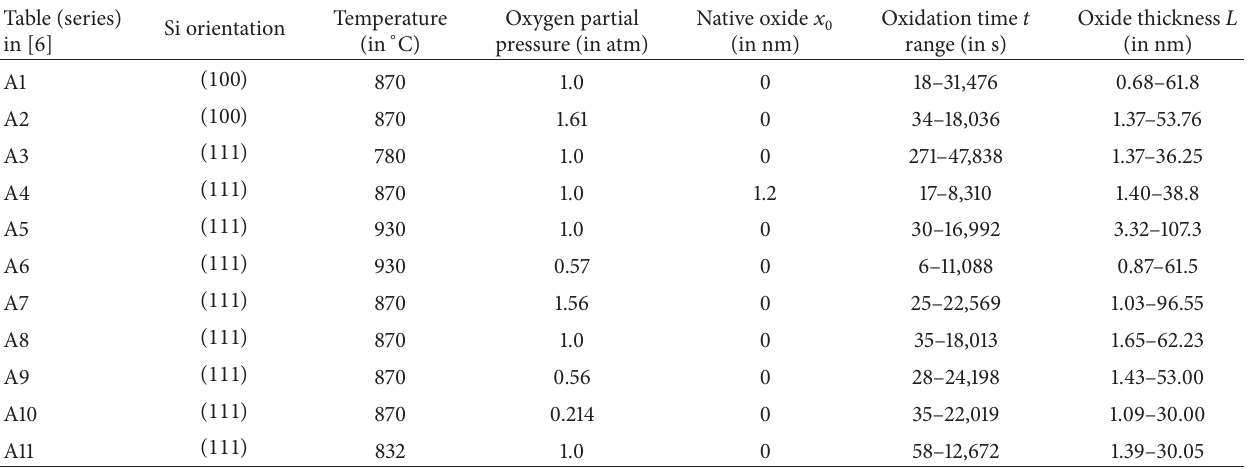
Table 1: Experimental data from [7] in [6].